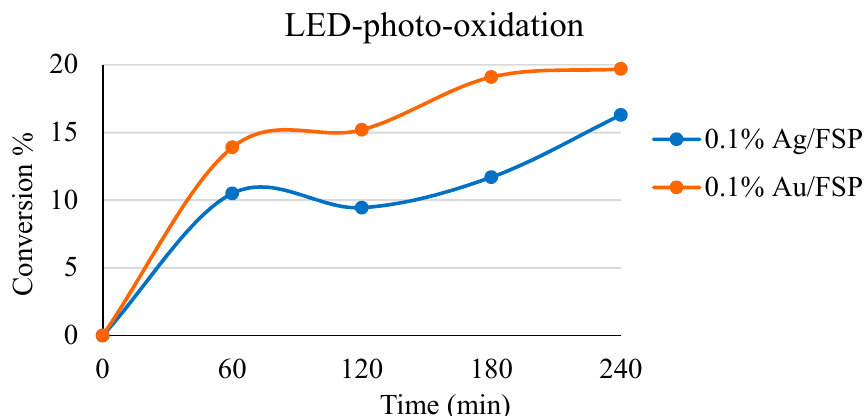
Figure 7. Photo-oxidation of NH 4 with various metal-promoted catalysts under LED lamp irradiation using 0.01 mol of Figure 8. Photo-oxidation of NH 4 in tap water with 0.1% Ag and 0.1% Au/FSP catalyst under LED NH 4 Cl, 0.2 g of photocatalyst, pH 5, r.t. and 250 mL of solution. lamp irradiation using 0.01 mol of NH 4 Cl, 0.2 g of photocatalyst, pH 5, r.t. and 250 mL of solution.